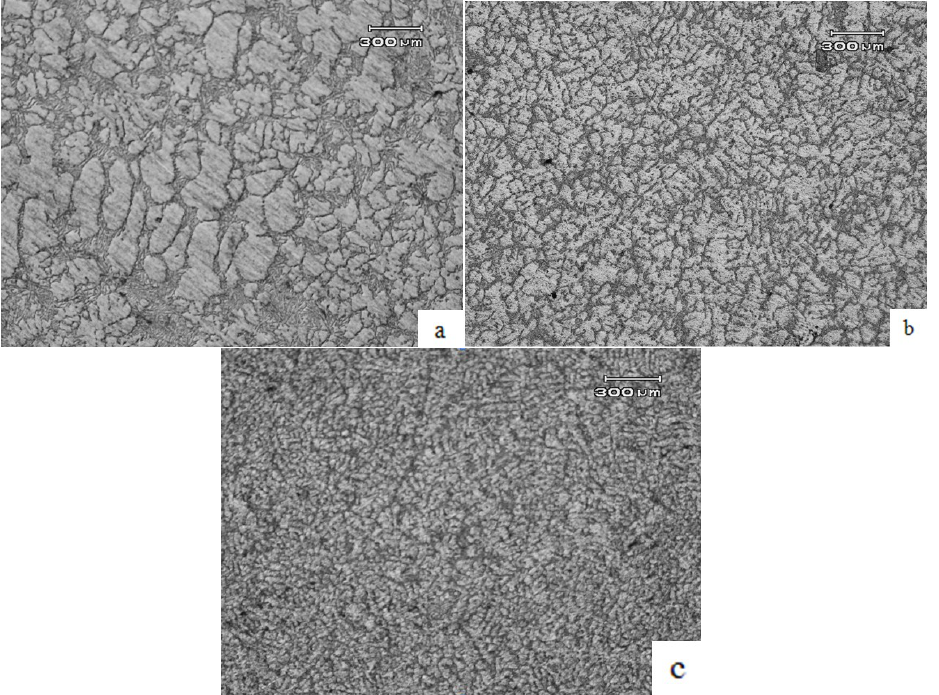
Figure 10. The microstructure obtained for different stirring speeds for the casting